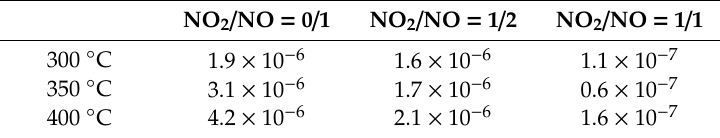
Figure 13. NO 2 / NO = 1 / 1, 400 ◦ C, comparison of C NH Table 5. Mean absolute error for Figures 5–13.